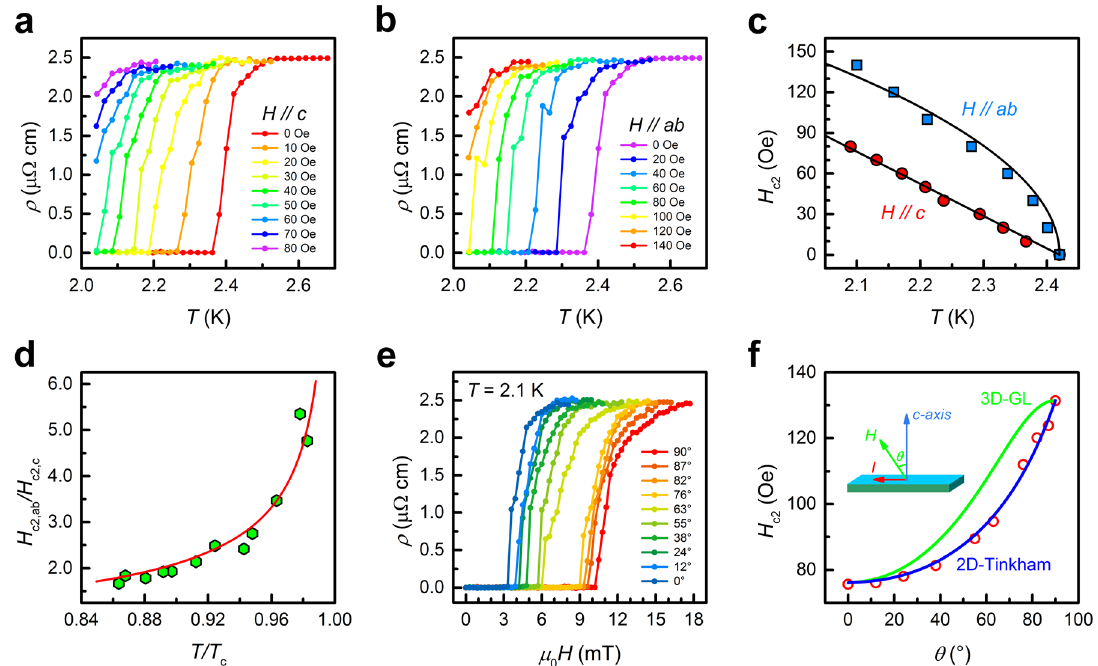
Fig. 3 Mixed-state magnetotransport properties of single crystal AuSn 4 . Temperature dependence of resistivity in magnetic fi elds parallel to: a the crystal c -axis and b ab plane. c Upper critical fi elds H c2, c ( T ) and H c2, ab ( T ) for an AuSn 4 crystal. d The H c2, ab / H c2, c ratio vs. reduced temperature T / T c . Solid lines represent the fi ts to the data. e Magnetic fi eld dependence of the resistivity under different θ at 2.1 K. f The angular dependence of the upper critical fi eld H θ ), as extracted from e . The blue solid line and the green solid line represent the fi tting with the 2D Tinkham formula and the 3D anisotropic mass c2 ( model, respectively. The inset is a schematic drawing of a tilt experimental setup, where θ is the tilted angle between the normal of the sample plane and the direction of the applied magnetic fi eld. The direction of applied current I is also